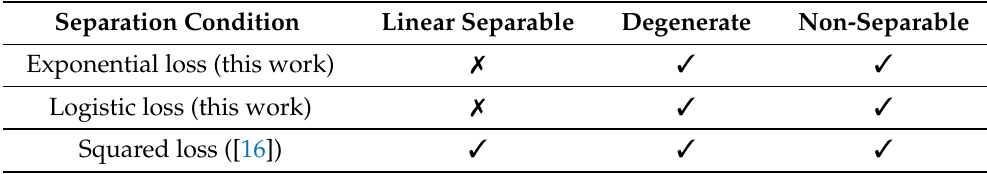
Table 2. A summary of the relationship between separation conditions of the data and the catapult phase for different